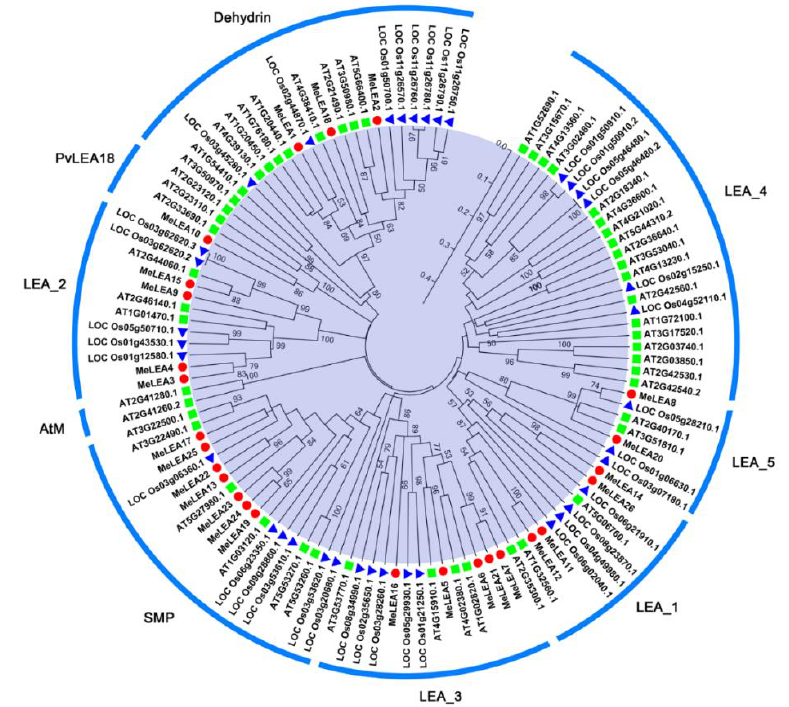
Figure 1. Evolutionary analysis of the LEAs from cassava, rice, and Arabidopsis . A total of 26 LEAs from cassava, 37 LEAs from rice and 51 LEAs from Arabidopsis were used to create the neighbour-joining (NJ) tree with 1000 bootstraps. Red circle, LEAs in cassava; Green square, LEAs in Arabidopsis ; Blue triangle, LEAs in rice.